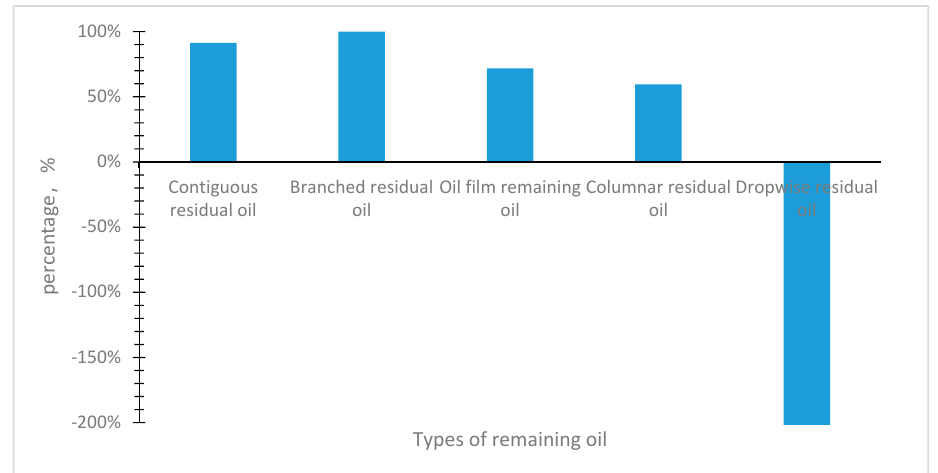
Figure 8. Total improvement percentage of displacement efficiency of different types of remaining oil. When the displacement rate increases from 0.05 to 0.5 mL/min, i.e., the cumulative PV number increases from 5.1 to 80.0, the proportion of different remaining oil changes significantly. When the water drive rate is low, the remaining oil mainly exists in the con- tiguous type, and part of the remaining contiguous oil is displaced. Part of the remaining contiguous oil is transformed into other types of remaining oil (mainly in the form of the oil film in the early stage and mainly in the form of column and drop in the later stage). At the end of displacement, the remaining oil mainly exists in the form of drop, column, and oil film. (Figures 9 and 10).